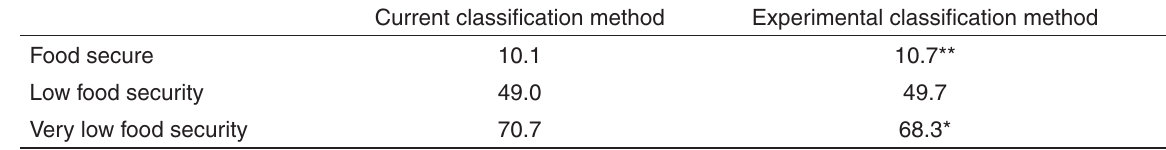
Asterisks show statistically significant difference as follows: * = p < 0.05 and ** = p < .01. Estimates are weighted to represent the U.S. population. N=101,913